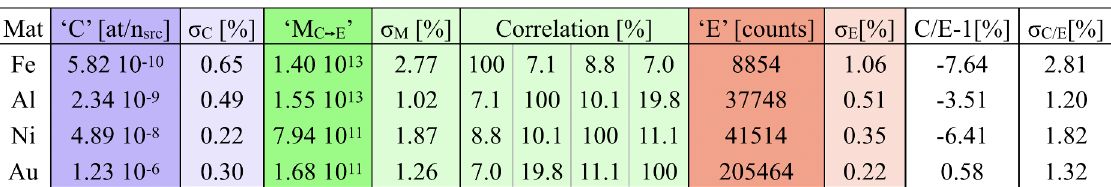
Figure 7: Calculation (blue) vs experimental (red) comparison using the model (green) with its correlation